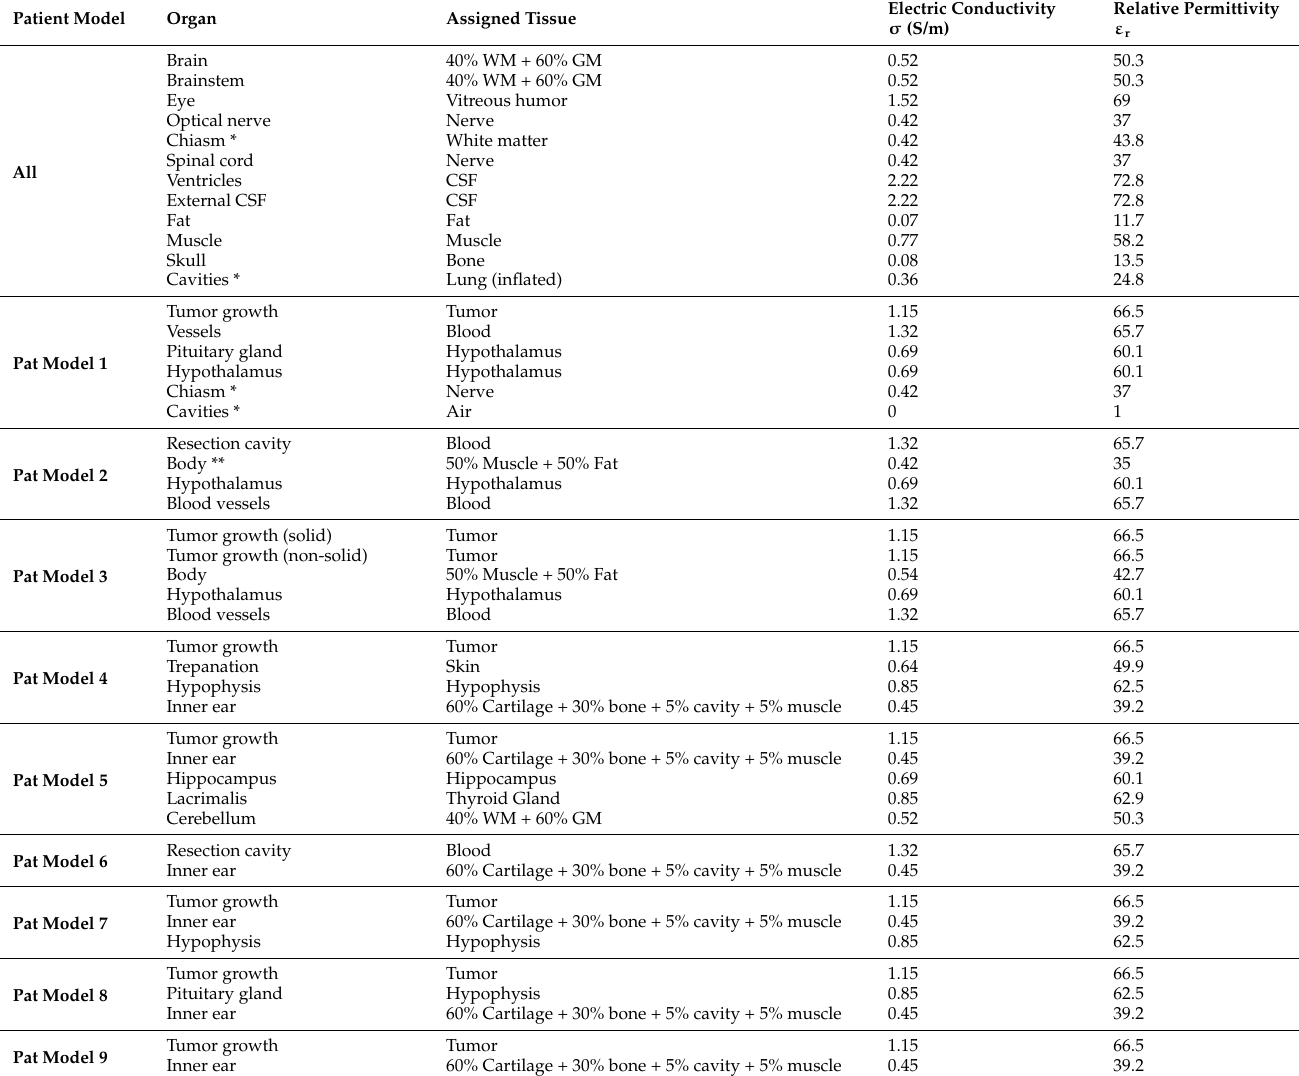
Table 1. Segmented target volumes and organs at risk with their assigned tissue types and dielectric properties for EMF simulations. Dielectric properties of healthy tissue were taken from the IT’IS database [48,49]. Solid tumor tissue was assigned the average of two values reported from the only in vivo measurement known to the authors [47]. Some organs and tissues were delineated for all patient models, while specific organs at risk were selected based on the individual location of the target volume. * Upon further discussion throughout the patient model creation, changes in the assigned dielectric properties were made, for example addressing the fact that cavities in the human head are typically not empty and should thus not be simulated as pure air. Comparison studies were performed (data not shown here) and showed no significant influence, even for the fairly large difference in conductivity and relative permittivity in the cavities. This is most likely due to the small geometrical extent and the comparatively large SAR averaging volume. ** The manual organ contouring sometimes generated residual voxels not assigned to any specific organ. These voxels were assigned averaged properties of muscle and